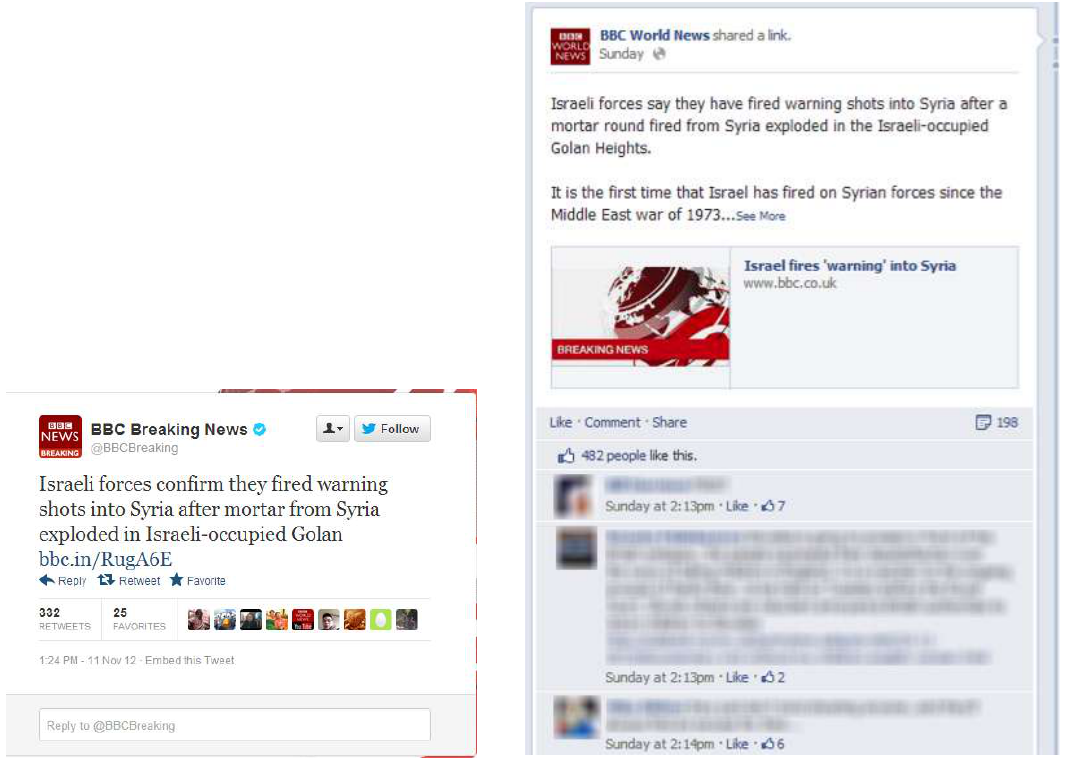
Figure 8: BBC News Story Published on Twitter 12 (Cp. left) and Facebook 13 (Cp.